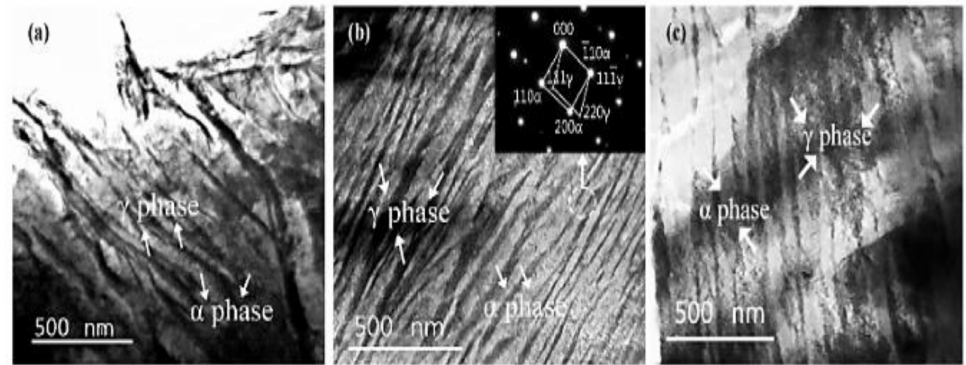
Figure 18. Typical TEM images of ( a ) austempered ductile iron specimen, ( b ) austempered ductile iron specimen after partitioning at 200 ◦ C for 30 min, and ( c ) austempered ductile iron specimen after partitioning at 300 ◦ C for 30 min [42].